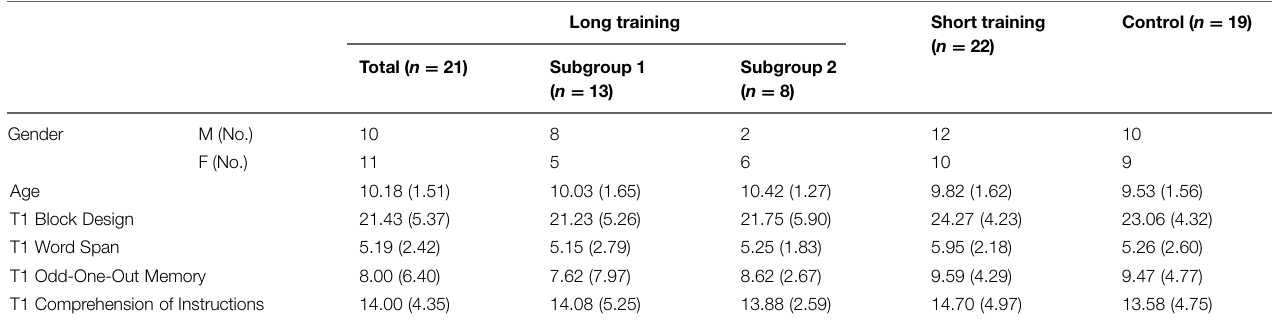
TABLE 1 | Comparisons before training of the groups from our project (Long training) and the Söderqvist study (Short training and Control) on contribution of genders, means of age (years) and means of results on cognitive tests (T1). Long training